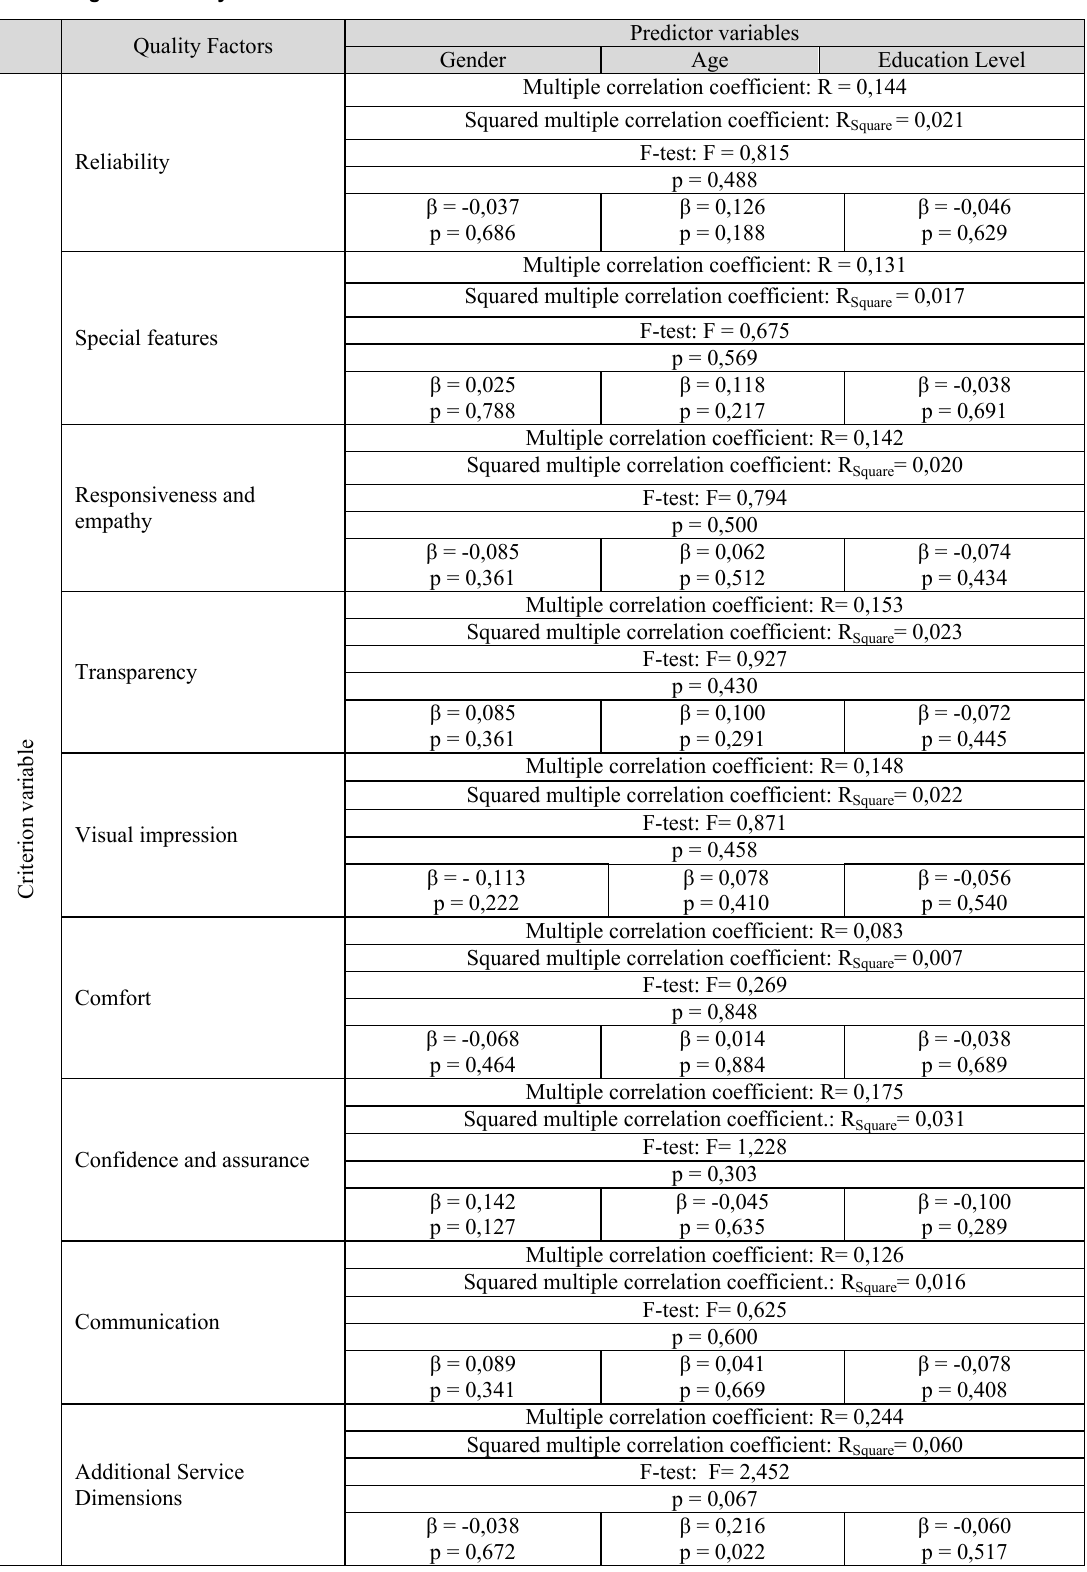
Table 1: Regression analysis results Quality